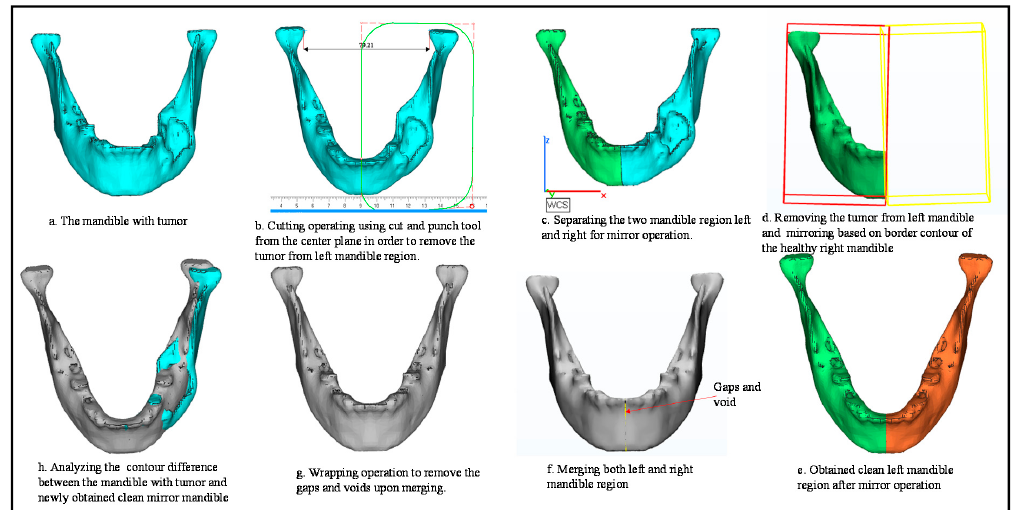
Figure 4. Steps involved in the three-dimensional reconstruction of the clean, healthy mandible using the mirroring